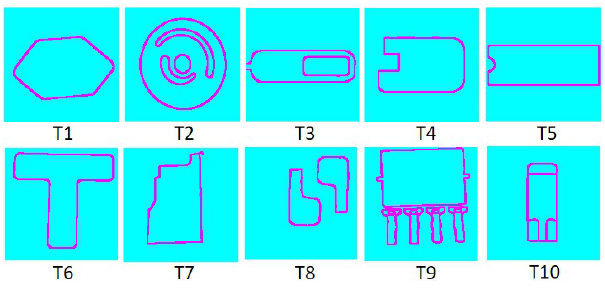
Figure 7. Template for objects in the test dataset, numbered from T1 to T10